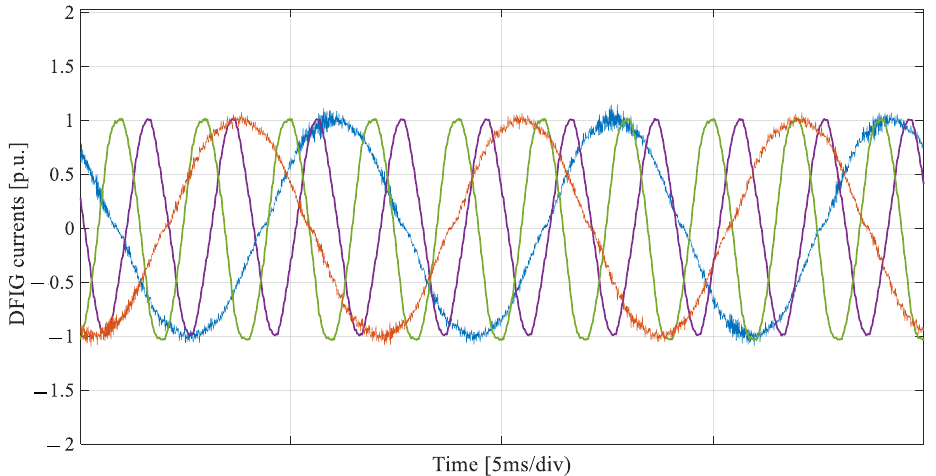
Figure 7. Behavior of the DFIG stator and rotor currents at the rated torque in the high speed re-